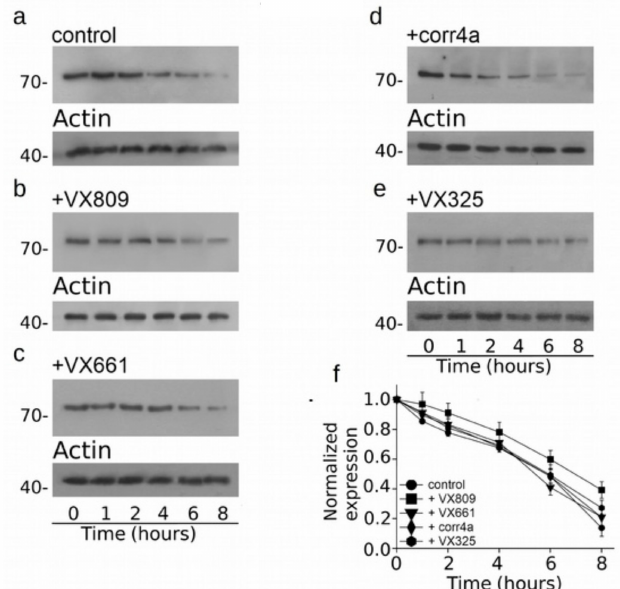
Figure 7. Evaluation of WT-M1N1 stability by means of the cycloheximide chase approach. Expression of the WT-M1N1 polypeptide in HEK-t cell lysates treated with DMSO ( a ), 5 µ M VX809 ( b ), 5 µ M VX661 ( c ), 10 µ M corr4a ( d ) and 5 µ M VX325 ( e ) and subjected to protein synthesis inhibition by